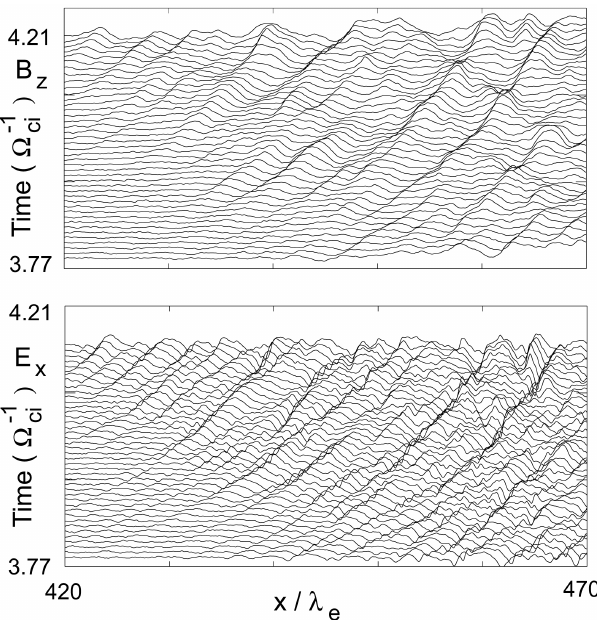
Fig. 9. Electric field E x component stacked in time. Time runs from bottom to top.